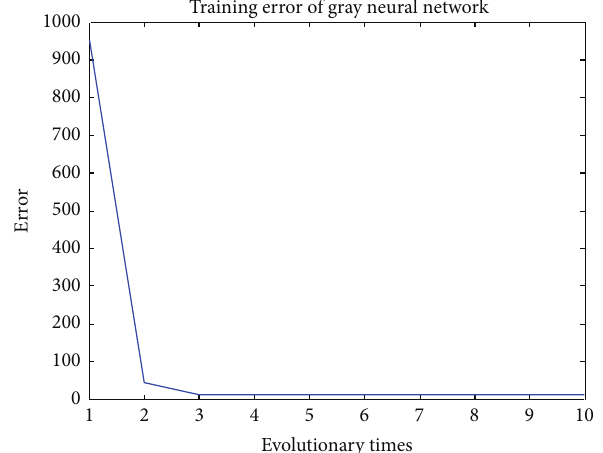
Table 4: The correlations among wind speed, temperature, and gas concentration.